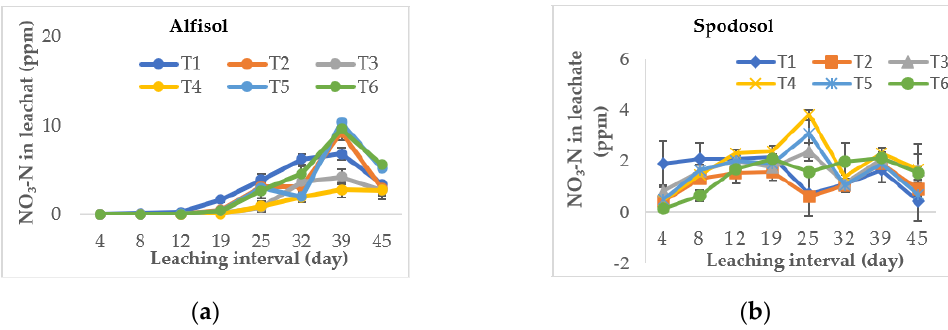
Figure 4. Effect of treatments on NO 3 ‐ N leaching at different leaching events from ( a ) Alfisol soil and ( b ) Spodosol soil.